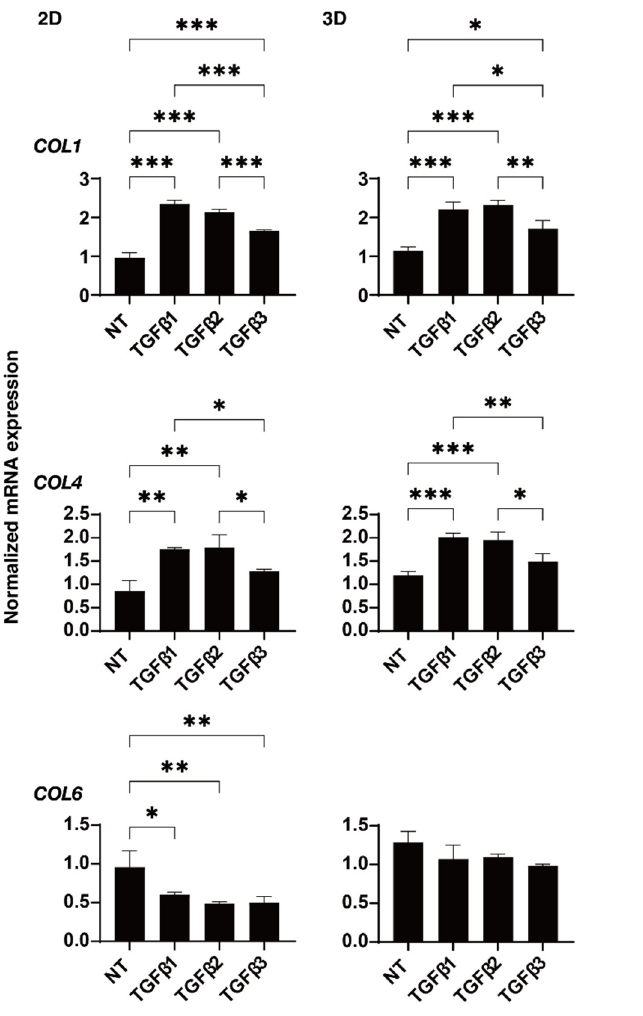
Figure 4. Effects of TGF ‐β isoforms on the mRNA expression of ECM molecules in 2D ‐ and 3D ‐ cultured HTM cells. At day 6, 2D ‐ and 3D ‐ cultured HTM cells (NT, non ‐ treated control) and cultures treated with 10 ng/mL TGF ‐β‐ 1, 5 ng/mL TGF ‐β‐ 2, or 1 ng/mL TGF ‐β‐ 3 were subjected to a qPCR